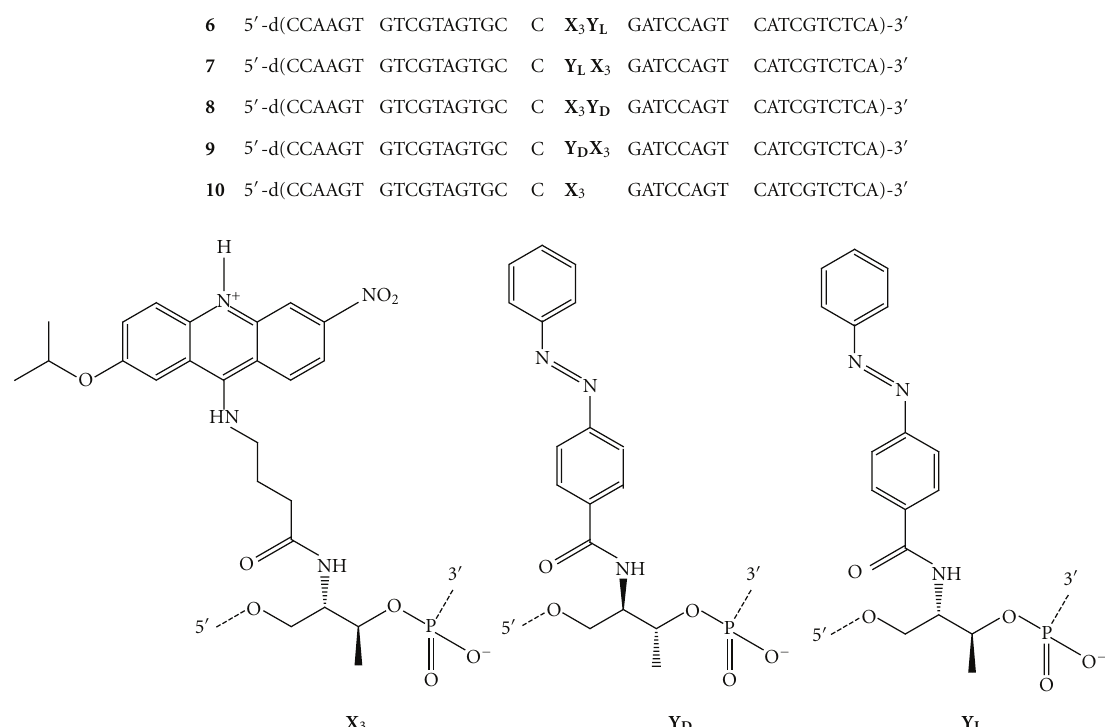
Figure 4: Structures of the modified DNA bearing more active acridine ( X 3 ) and the two azobenzene residues ( Y D and Y L ).